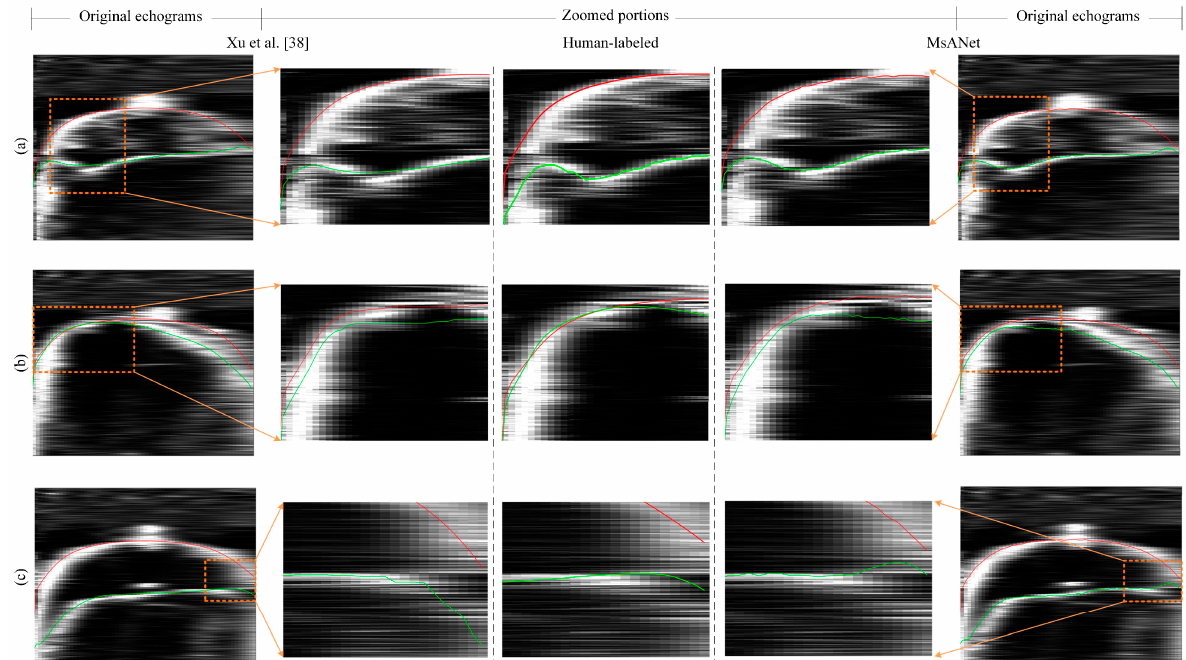
Figure 10. Visualization of comparisons of zoomed portions of the extraction results of Xu et al. [38] and the MsANet. ( a – c ): Three set of comparison of extracted zoomed ice-surface layer positions and ice-bottom layer positions obtained by human labeled, method of Xu et al. [38], and method of MsANet.